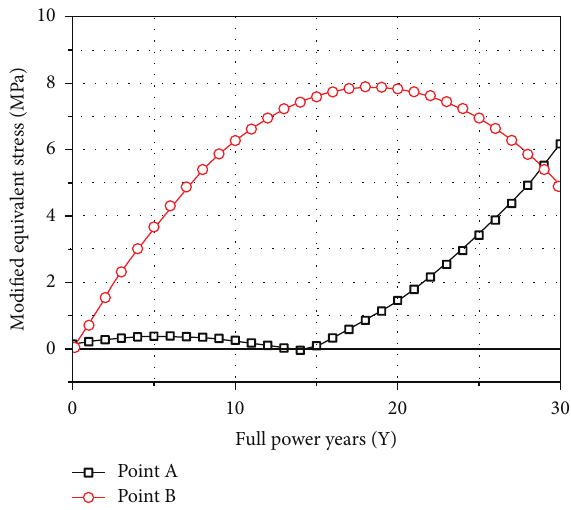
Figure 8: Stress history in service life of H-451 graphite brick.